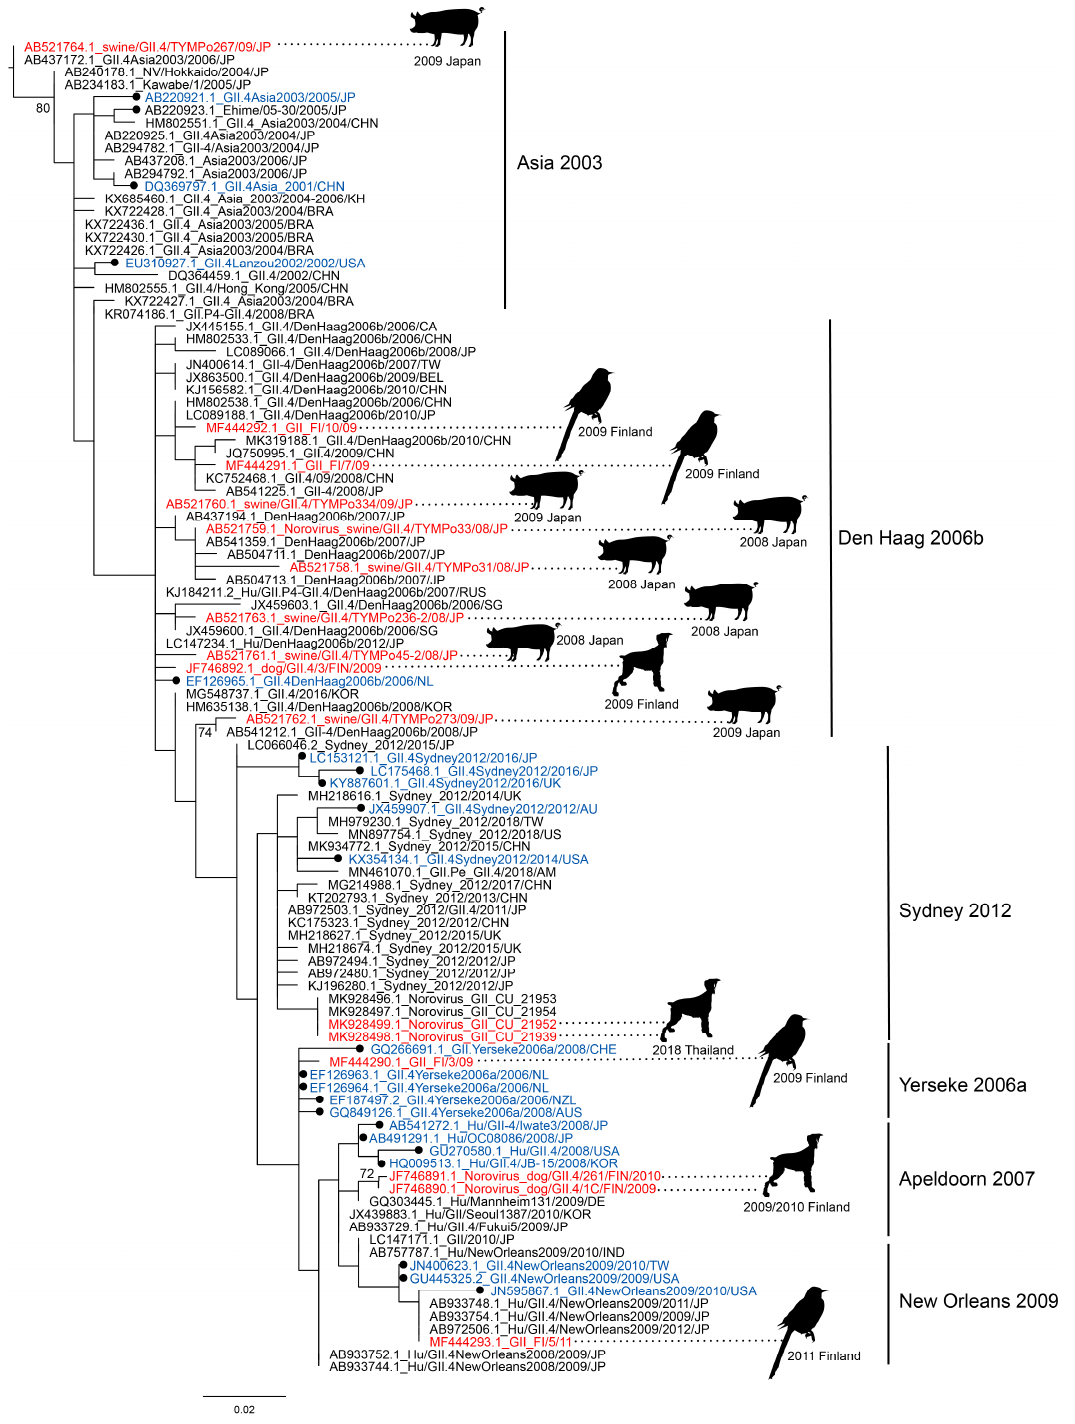
Figure 1. Genetic characterization of GII.4 sequences found in animals. A maximum-likelihood tree based on 223 bp GII.4 sequences was inferred with PhyML v3.0 software using the general time reversible nucleotide substitution model (GTR + G). Sequences that were found in animals (red) were aligned with most closely related human sequences (black) and the reference sequences from the noronet typing tool (blue, black circle). The animal in which norovirus was found as well as the date and country of collection are indicated next to the sequence. The scale bar indicates nucleotide substitutions per site.